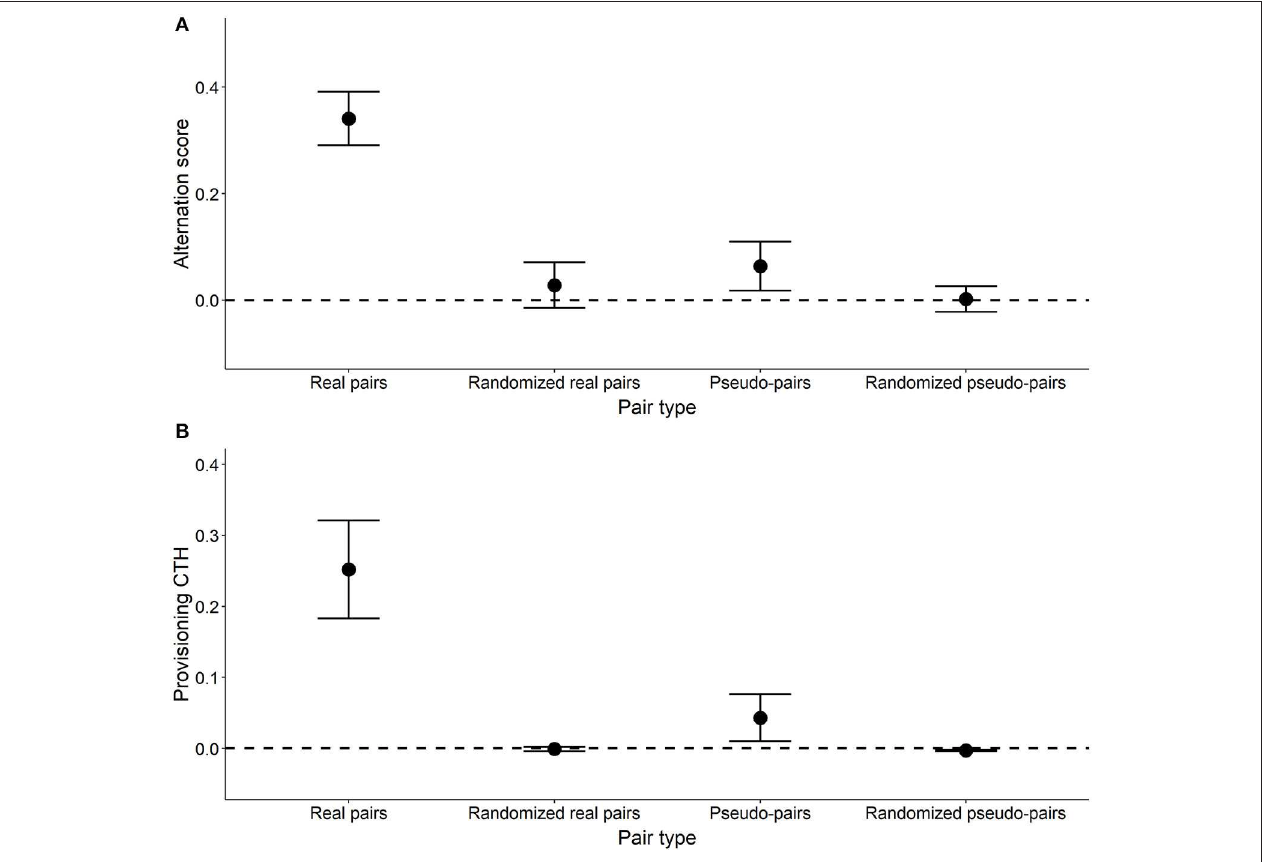
FIGURE 6 | Alternation score (A) and provisioning CTH (B) in real, randomized real, pseudo- and randomized pseudo-pairs. Points designate the mean ± SE. For pairs and pseudo-pairs, these statistics are based on the value for each pair ( n = 17) or pseudo-pair ( n = 58). For randomized pseudo-pairs and randomized real pairs, mean ± SE are based on the mean values of the 10,000 randomized distributions for each of the pairs and pseudo-pairs. An alternation score of zero (dashed line) represents the amount of alternation expected by chance, assuming that the probability of a provisioning visit by each parent is constant with respect to